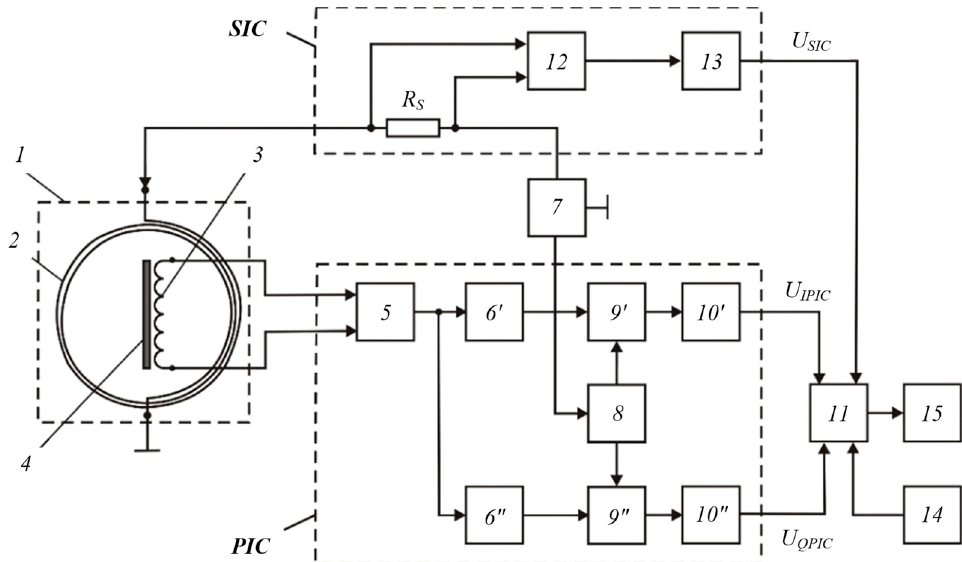
Figure 3. Metal detector diagram: 1 is the instrumentation probe; 2 is the frame antenna; 3 is the receiver coil; 4 is the ferrite core; 5 is the instrumentation amplifier; 6 ′ and 6 ″ are buffer amplifiers; 7 is the generator that produces sinusoidal voltage at sound frequencies; 8 is the generator of quadrature reference voltage; 9 ′ and 9 ″ are synchronous detectors (SD); 10 ′ and 10 ″ are the ADC units; 11 is the computational unit; 12 is the current meter; 13 is the ADC unit; 14 is data input device; 15 is the indicator; R S is the measuring shunt. The elements (3) and (4) of the probe (1) form the FR. The FT (2) is orthogonal to the receiver coil (3) of the FR to attain the required geometric compensation of the primary field for the FR.